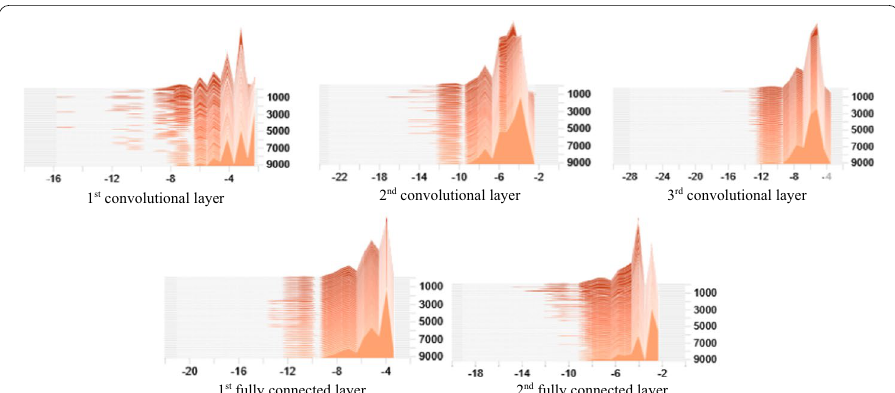
Fig. 6 Weights exponent values utilization during training of the network (per training batch) [44]